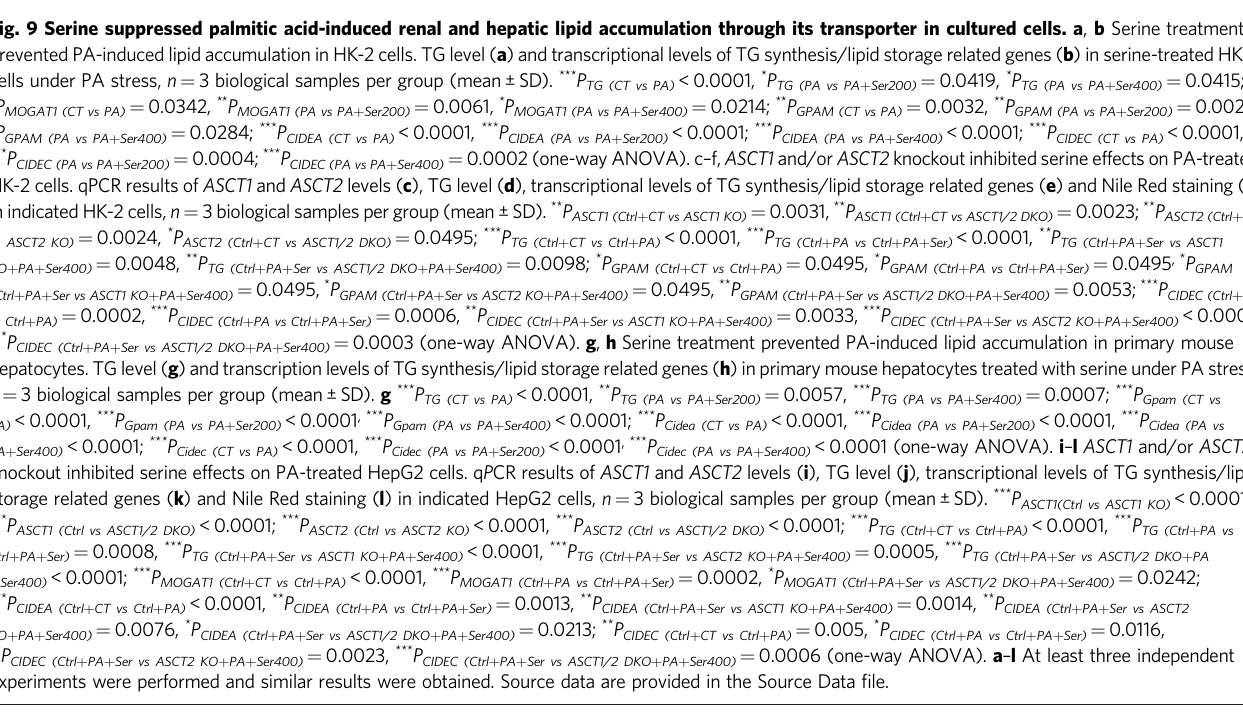
Fig. 9 Serine suppressed palmitic acid-induced renal and hepatic lipid accumulation through its transporter in cultured cells. a , b Serine treatment prevented PA-induced lipid accumulation in HK-2cells.TGlevel ( a ) and transcriptional levels of TGsynthesis/lipid storage related genes ( b ) in serine-treated HK-2 cells under PA stress, n = 3 biological samples per group (mean±SD). *** P TG (CT vs PA) <0.0001, * P TG (PA vs PA + Ser200) = 0.0419, * P TG (PA vs PA + Ser400) = 0.0415; = 0.0342, * * P = 0.0061, * P = 0.0214; * * P = 0.0032, * * P = 0.0025, * P MOGAT1 (CT vs PA) MOGAT1 (PA vs PA + Ser200) MOGAT1 (PA vs PA + Ser400) GPAM (CT vs PA) GPAM (PA vs PA + Ser200) = 0.0284; * ** P * P * ** P *** P *** P GPAM (PA vs PA + Ser400) CIDEA (CT vs PA) <0.0001, CIDEA (PA vs PA + Ser200) <0.0001; CIDEA (PA vs PA + Ser400) <0.0001; CIDEC (CT vs PA) <0.0001, = 0.0004; *** P = 0.0002(one-wayANOVA).c – f, ASCT1 and/or ASCT2 knockoutinhibitedserineeffectsonPA-treated *** P CIDEC(PAvsPA + Ser200) CIDEC(PAvsPA + Ser400) HK-2 cells. qPCR results of ASCT1 and ASCT2 levels ( c ), TG level ( d ), transcriptional levels of TG synthesis/lipid storage related genes ( e ) and Nile Red staining ( f ) inindicatedHK-2cells, n = 3biologicalsamplespergroup(mean±SD). ** P ASCT1(Ctrl + CTvsASCT1KO) = 0.0031, ** P ASCT1(Ctrl + CTvsASCT1/2DKO) = 0.0023; ** P ASCT2(Ctrl +